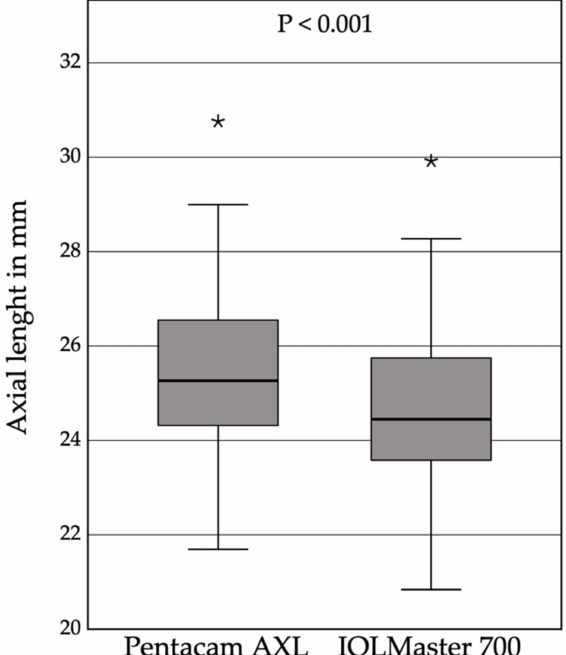
Figure 1. The boxplots of the mean axial length results of three consecutive measurements with the Pentacam AXL using the pseudophakic setting (25.53 ± 1.94 mm), and the IOLMaster 700 using the sil- icone oil pseudophakic setting (24.73 ± 1.97 mm), reveals a mean systematic offset of 0.80 ± 0.08 mm, (95% CI: 0.77, 0.83 mm), * outliers, p < 0.001. The mean systematic difference between both devices was 0.80 ± 0.08 mm (95% CI: 0.77, 0.83 mm), p < 0.001. For both devices, the CoV was below 1% (0.26 and 0.09 %,